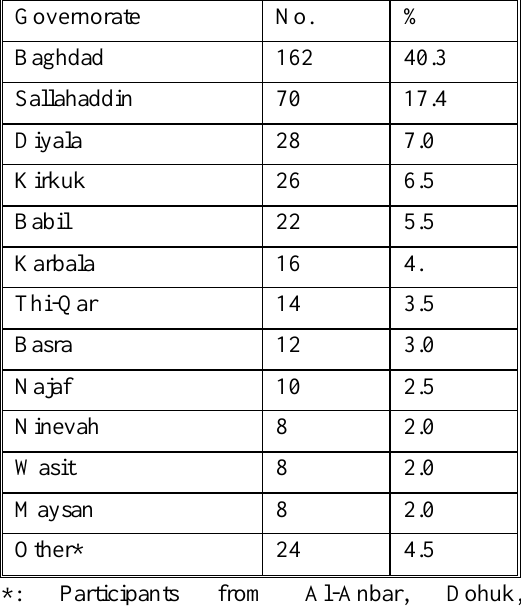
Table 1. Number and percentage of pharmacists